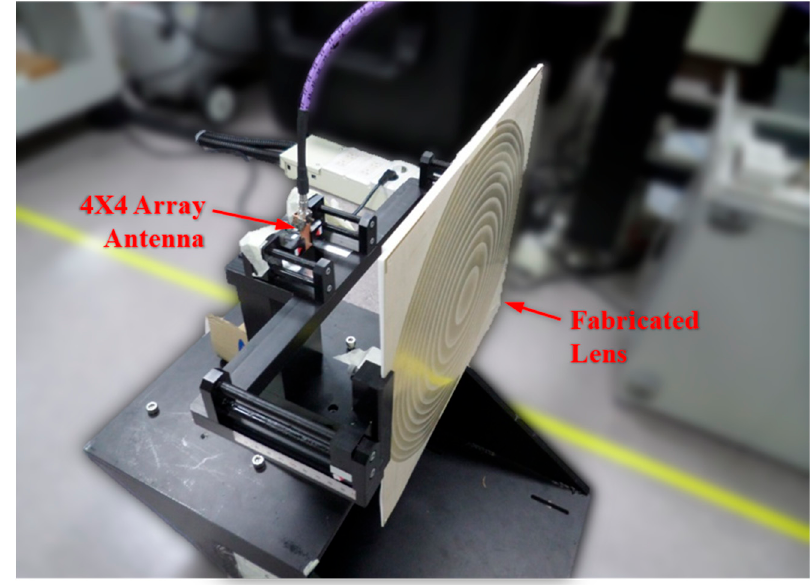
Figure 17. Measurement system and jig for the proposed lens.